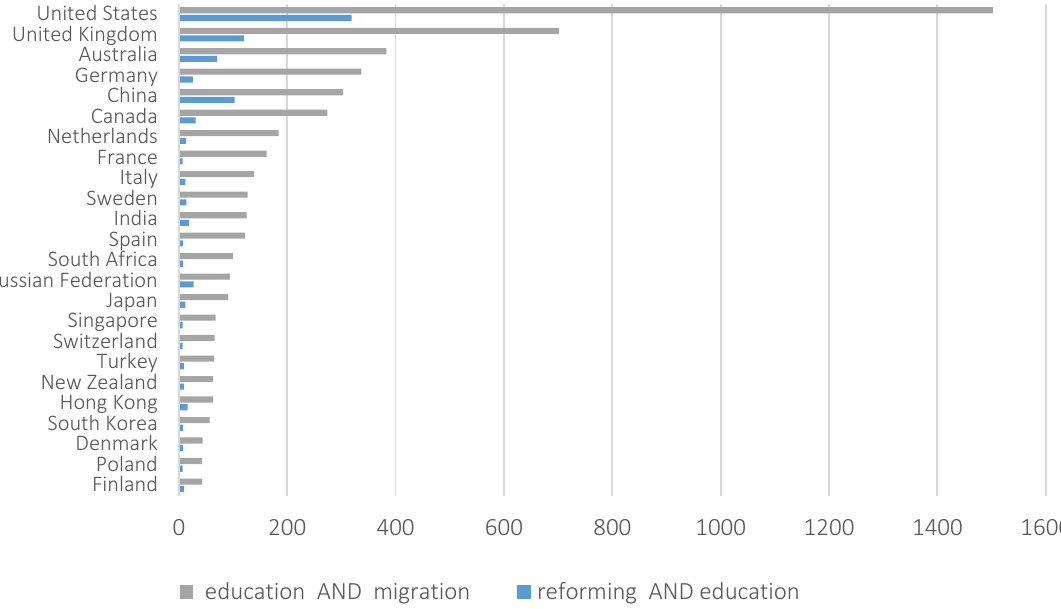
Figure 2. The geographic origin of the papers in the field, according to the search with